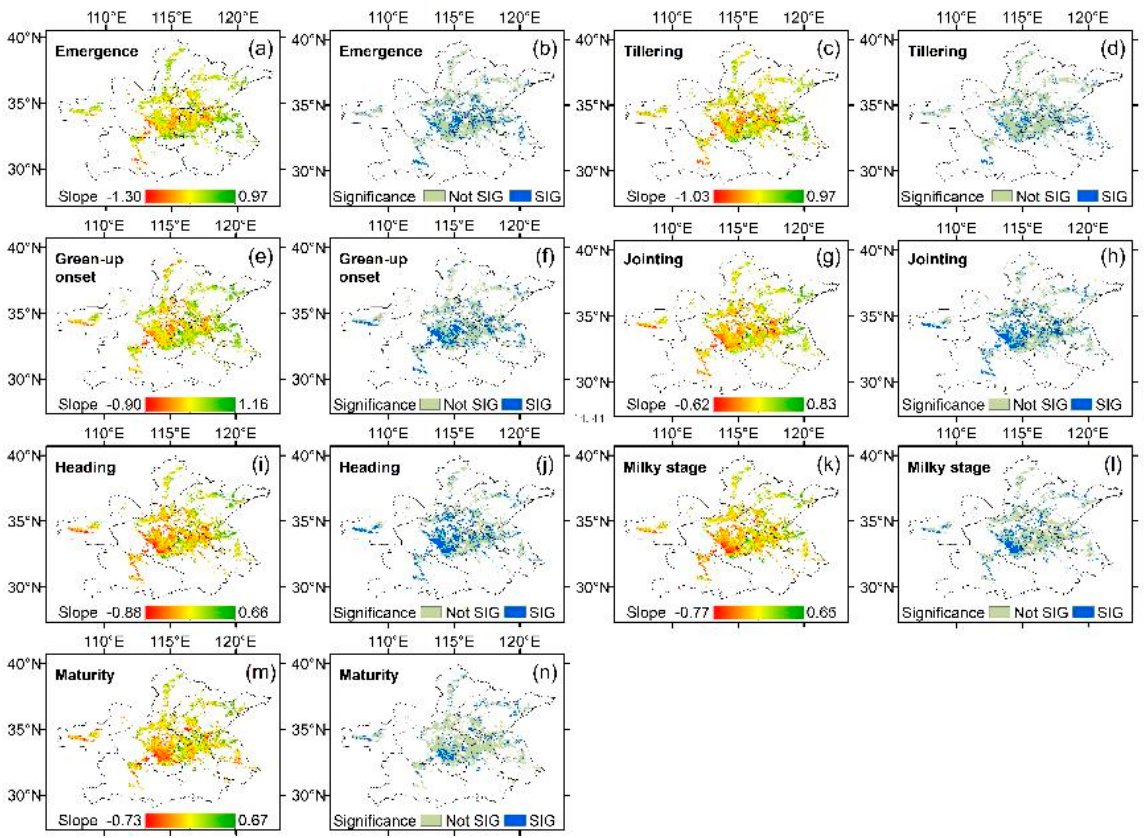
Figure 6. Phenological trends from 1981–1982 to 2015–2016. Negative slopes represent advanced phenological dates, and positive slopes, delayed dates. Wheat pixels with statistically significant trends (P < 0.05) are indicated in blue, and pixels without statistically significant trends are indicated in gray (P > 0.05). ( a , b ) represents trend and statistical significance of emergence, ( c , d ) represents trend and statistical significance of tillering, ( e , f ) represents trend and statistical significance of green ‐ up onset, ( g , h ) represents trend and statistical significance of jointing, ( i , j ) represents trend and statistical significance of heading, ( k , l ) represents trend and statistical significance of milky stage, and ( m , n ) represents trend and statistical significance of maturity, respectively. Table 2. Proportion of advance and delay of different phenological dates.